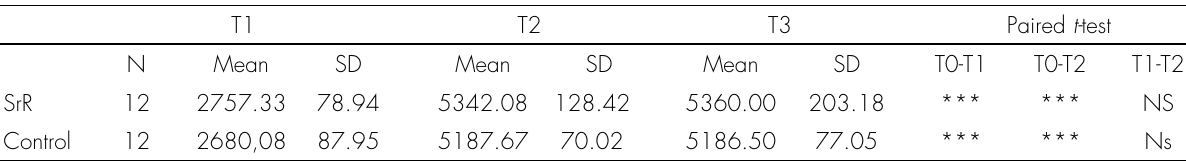
Table I. The mean measurement and standard deviations on the caliper measurements of width between the distal corner of the incisor at T1, T2, and T3 (µm).